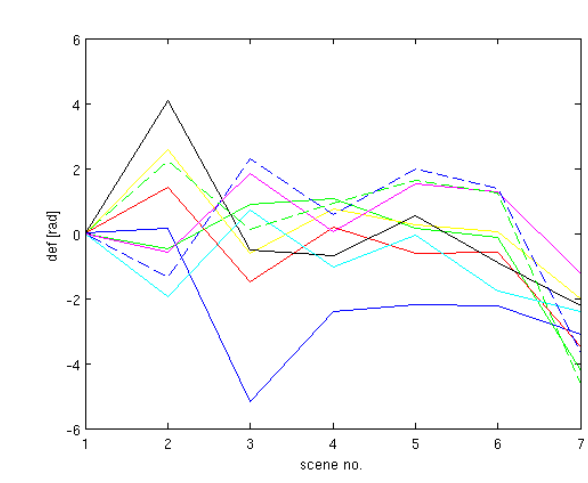
Figure 4: Deformations (together with other influences referring to a single acquisition, such as atmospheric delay, orbit errors etc.) of all reflectors wrt. reflector 1 (ref. 2 in solid blue, ref. 3 in solid green, ref. 4 in solid red, ref. 5 in solid yellow, ref. 6 in solid black, ref. 7 in solid cyan, ref. 8 in solid magenta, ref. 10 in dashed blue, ref. 11 in dashed green. Deformations are in radians, scenes are in the chronological order from June (all deformations are zero) to December. Except for the last acquisiton, the period between two acquisiton is 33 days (for the last scene, it is only 22